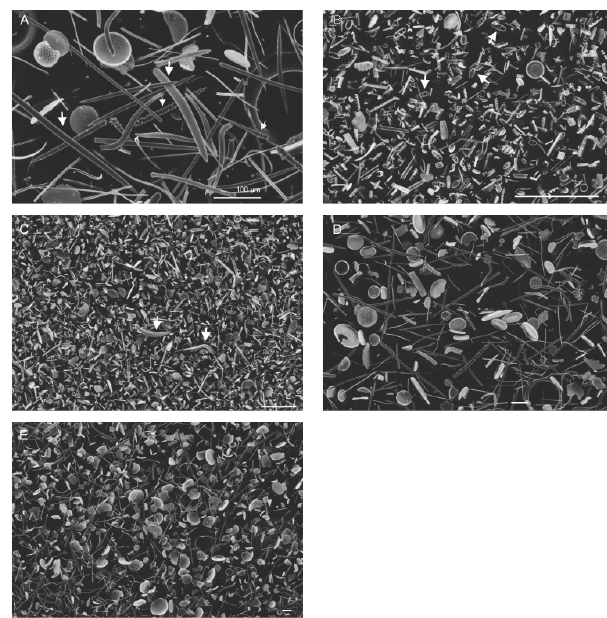
Figure 2: Examples of sample composition from SEM images: A: examples of sponge spicules from the >38 µm fraction of sample BS77 >38 µm highlighted by arrows; B; An example of the composition of the smaller size fraction with an abundance of Neodenticulata seminae and Neodenticulata koizumii indicated by arrows, BS77 3-15 µm; C: An example of the smaller size fraction with fragments of larger frustules as well as Proboscia spp (incicated). Thalassionema spp. and Thalassiothrix spp . BS48 3-15 µm; D: Detailed view of the >38 µm fraction showing the range of diatoms, BS77 >38 µm; E: Overview of the >38 µm fraction with examples of Coccinodiscus marginatus , Actinocyclus spp., Proboscia spp. Thalassionema spp. and Thalassiothrix spp . BS242 >38. All scale bars = 100 µm (See supplementary table for sample depths).